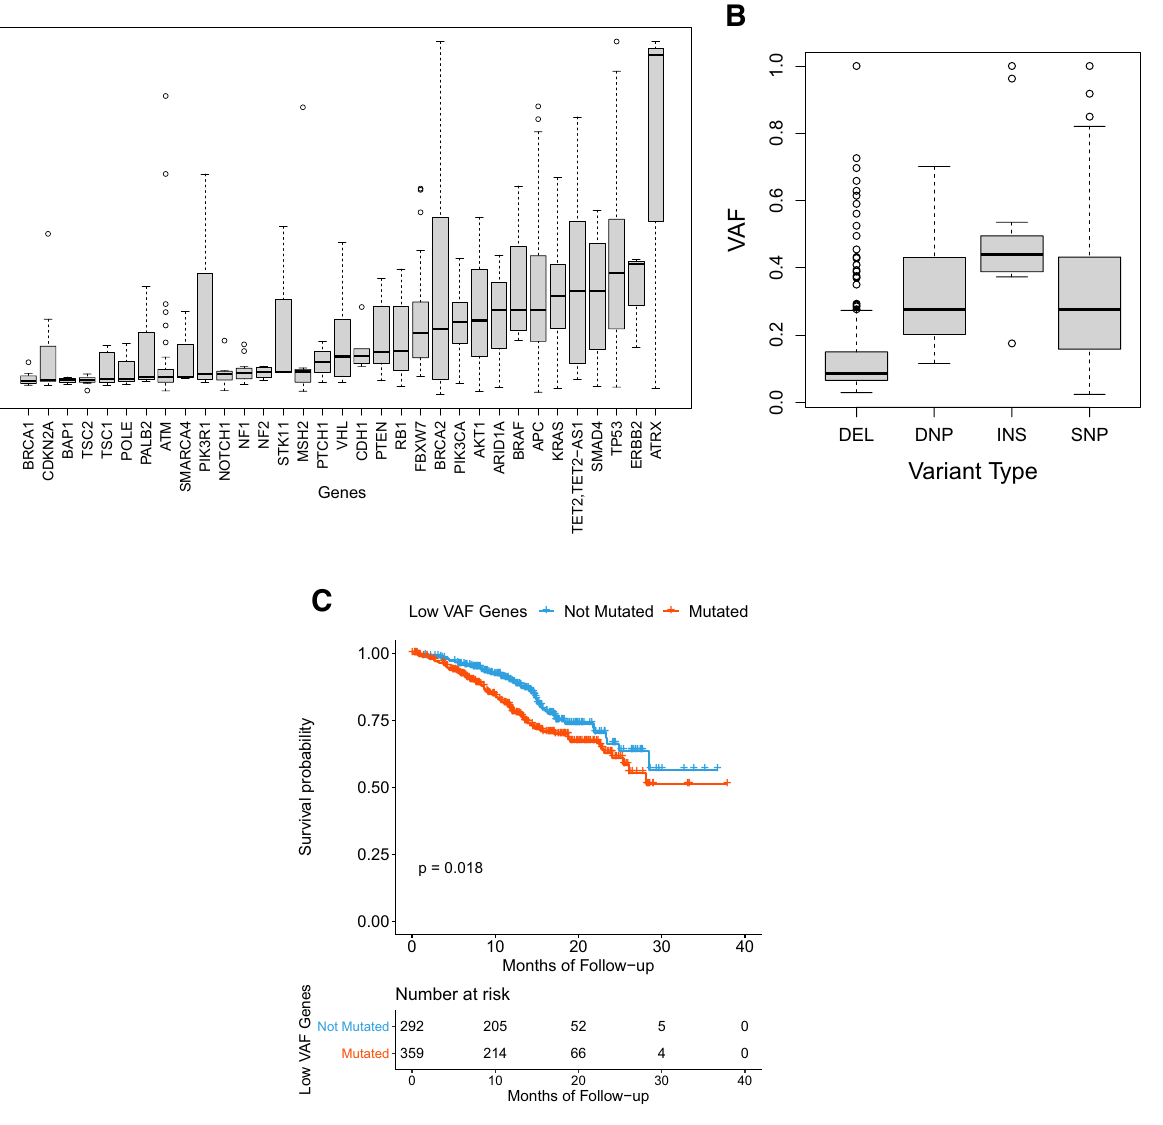
Figure 7. Gene-wise distribution of variant allele frequencies (VAF) for genes with more than two instances of somatic mutations ( A ), distribution of VAFs depending on mutation types ( B ), and Kaplan–Meier curve for OS in the MSKCC cohort stratified by presence of genes with relatively lower VAF ( C